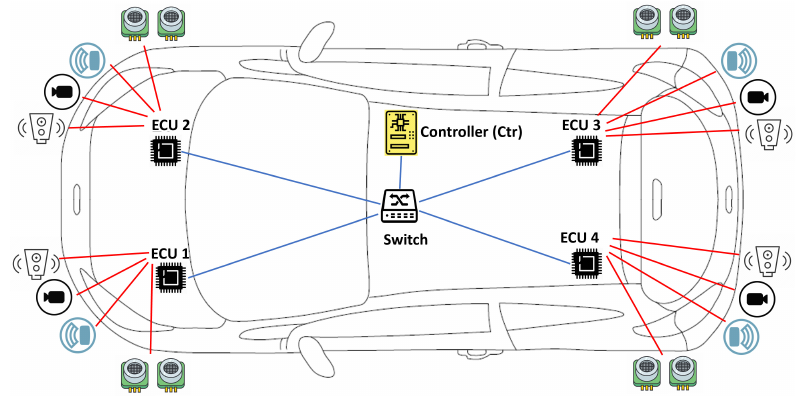
Figure 3. The simulated scenario.